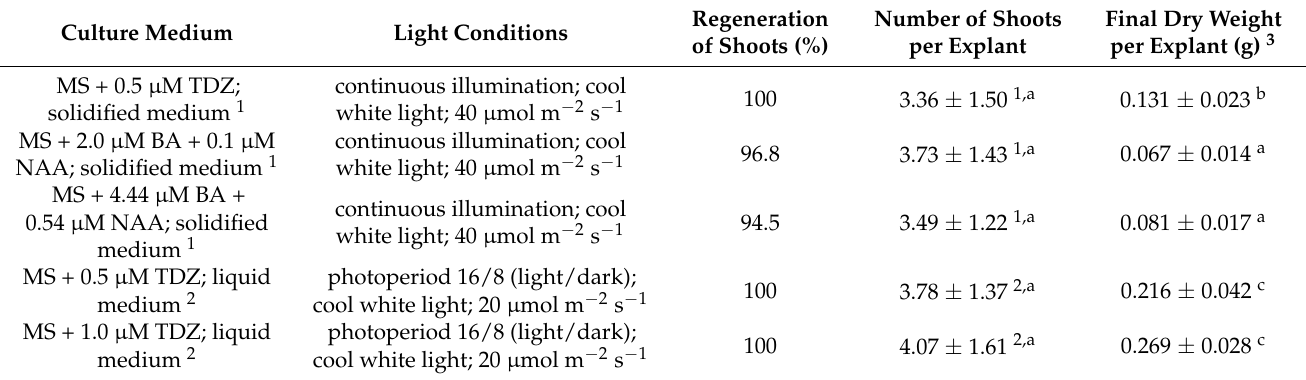
Table 1. Effect of the nutrient medium and light conditions on in vitro multiplication of shoots from the nodal explants of Carpesium divaricatum after 8 weeks of